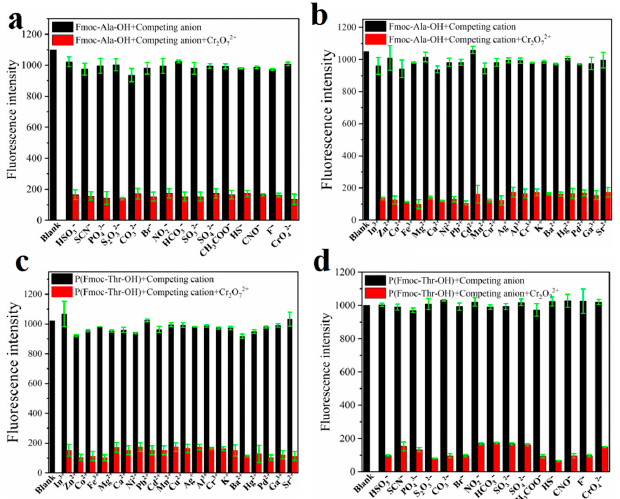
Figure 5. Fluorescence intensity of P(Fmoc-Ala-OH) ( a , b ) and P(Fmoc-Thr-OH) ( c , d ) in the mixed DMSO/EtOH ( v / v = 1:800) containing various ions. The black bars represent the addition of the competing ions to a solution of P(Fmoc-Ala-OH) and P(Fmoc-Thr-OH) . The red bars represent the change of the emission that occurs upon the subsequent addition of Cr 2 O 7 2 − to the above